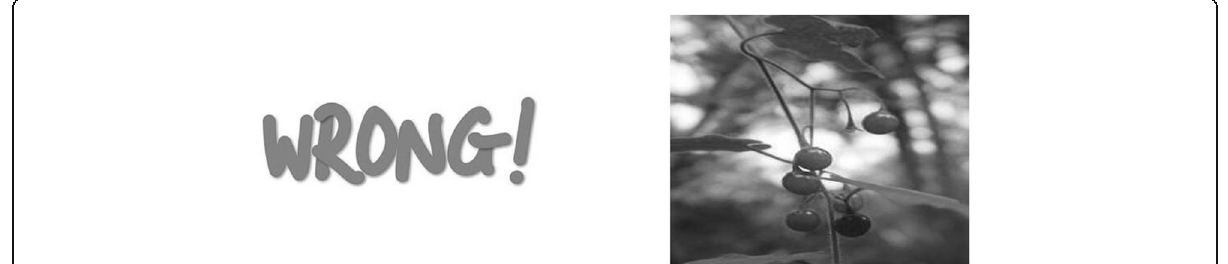
Fig. 12 Attacked with Gaussian noise and extracted hidden image (Example 2)